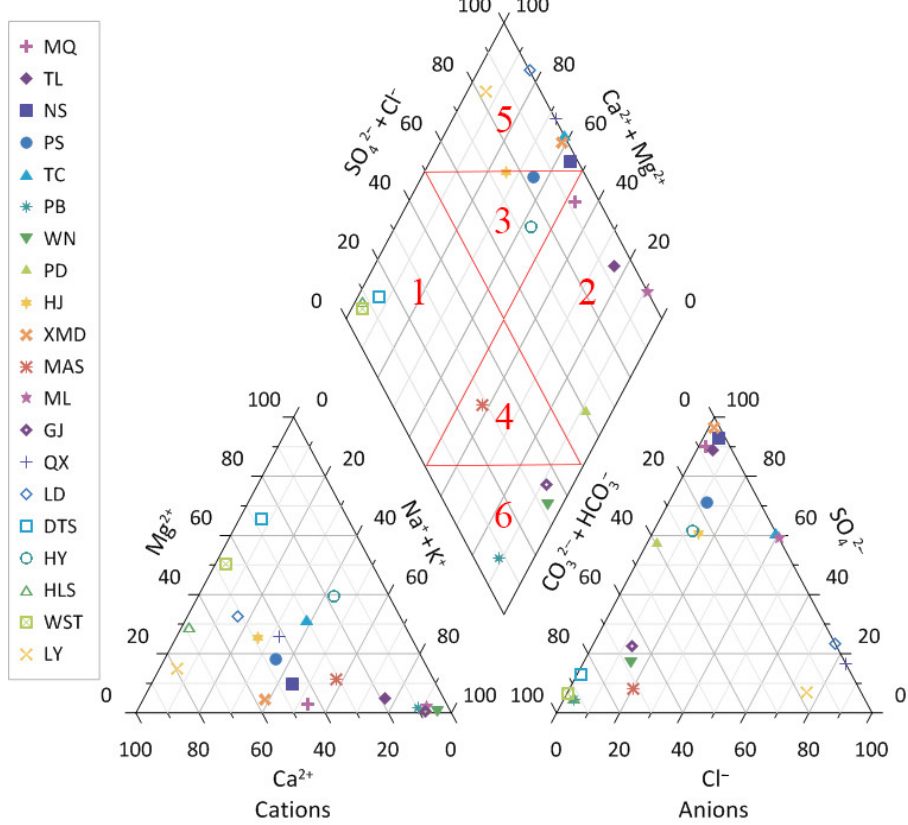
Figure 5. Piper diagram showing major ion chemistry of the sampled points.